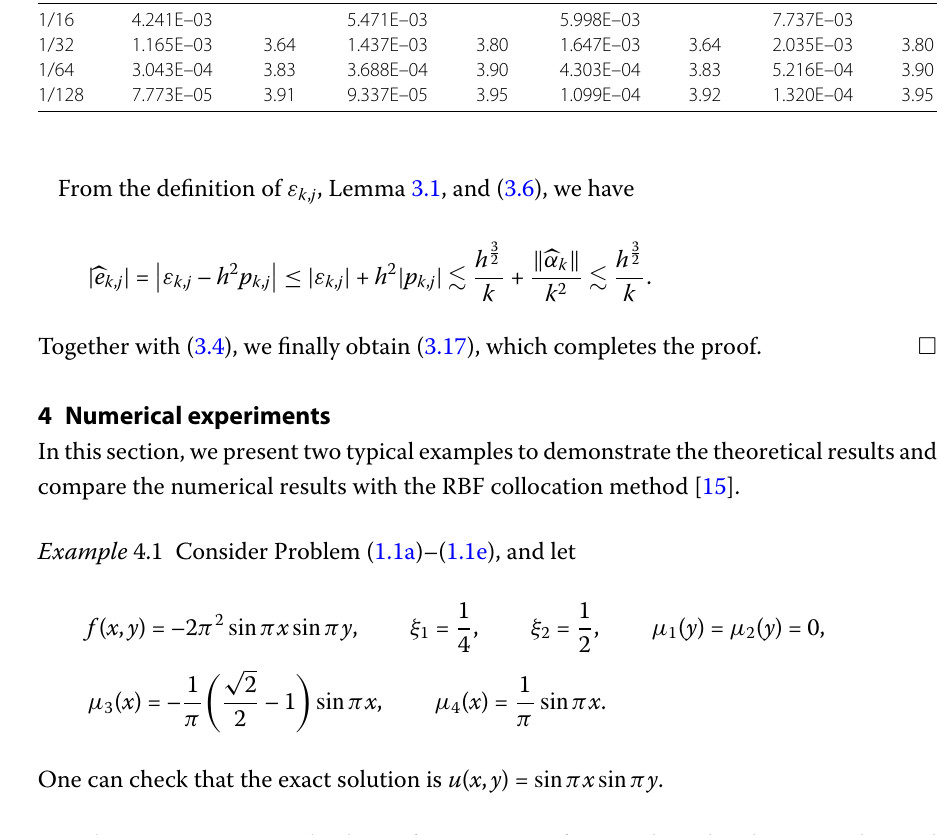
Table 2 The errors for finite difference method in the sense of pointwise ( x , y ) (0.25,